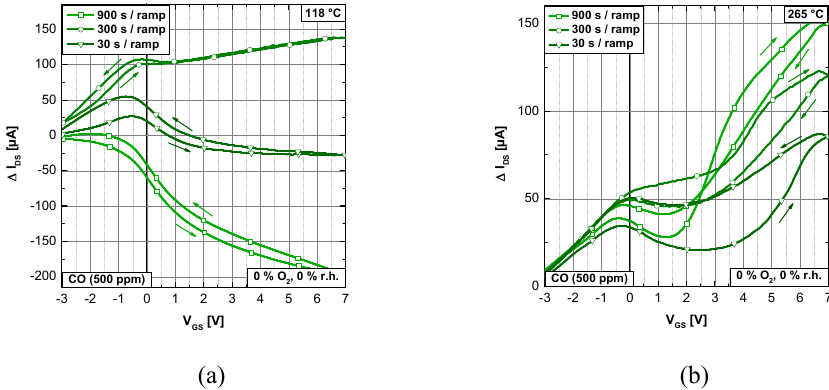
Figure 10. Hysteresis for CO (500 ppm) in dry nitrogen at 118 ◦ C (a) and 265 ◦ C (b) for di ff erent ramp durations (rectangles: 900s; circles: 300s; triangles: 30s).